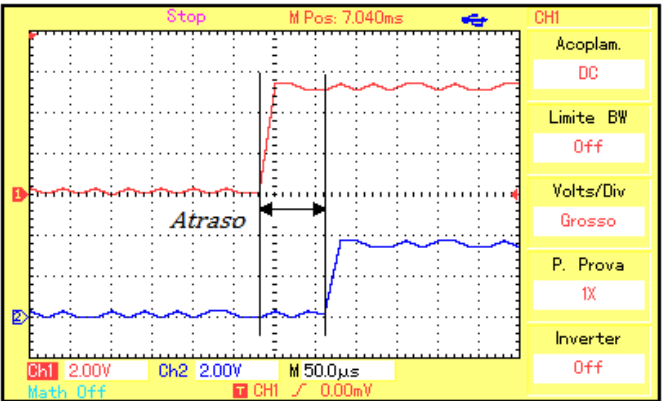
Figura 9: Passagem do 4º Zero para o 2º Um da sequência. Fonte: Autores, (2018).